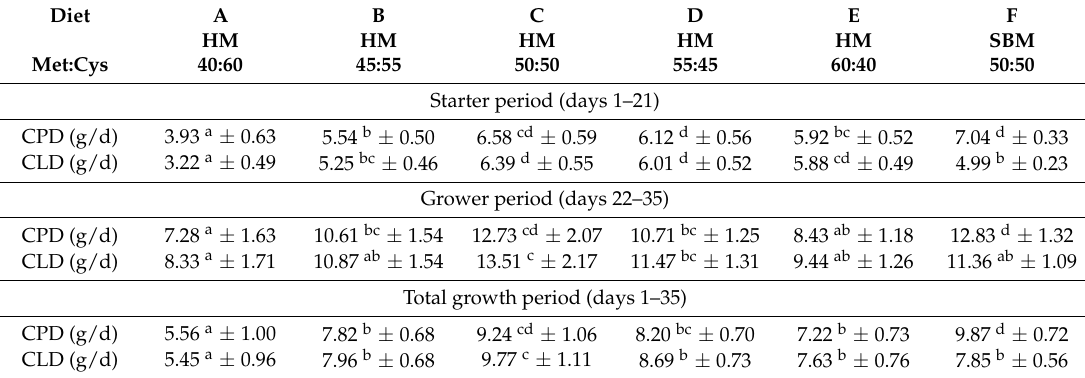
Table 7. Body crude protein (CPD) and body crude fat deposition (CLD) in the growth periods 1